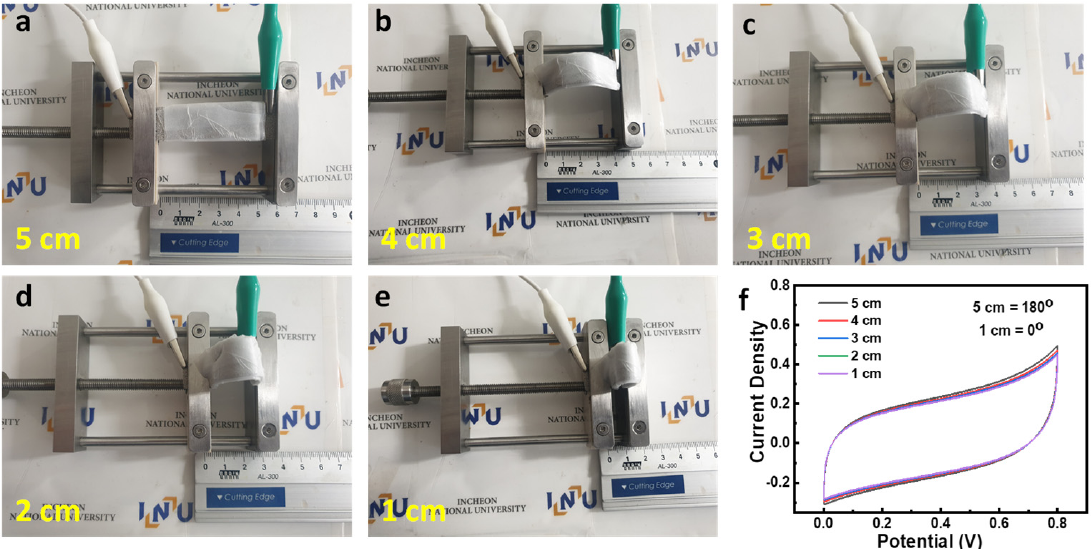
Figure 4. ( a – e ) Mechanical testing of a fabricated SSC device at various bending states and ( f ) the corresponding CV graph for a fabricated INSC − based SSC device.